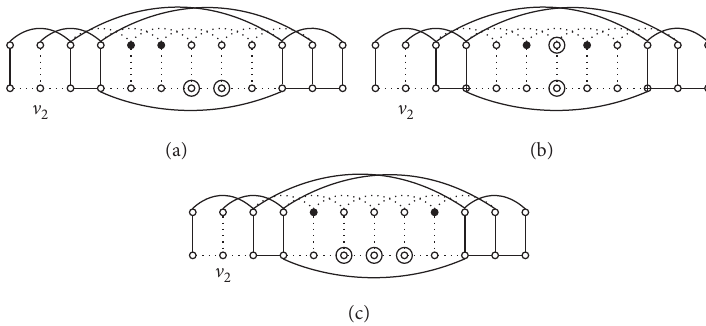
Figure 2: The four possible cases of S in Subcase 3.